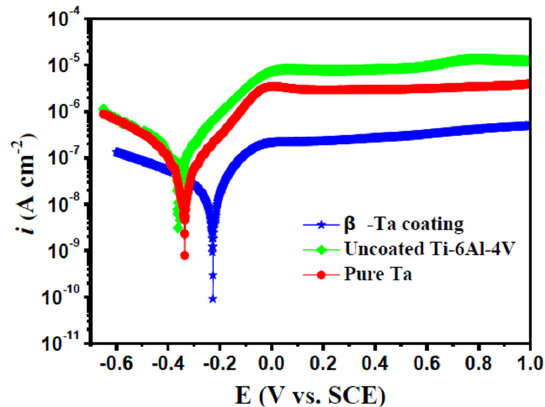
Figure 5. Potentiodynamic polarization curves for the β -Ta coating, uncoated Ti-6Al-4V and commercially pure Ta in Hank’s solution at 37 ◦